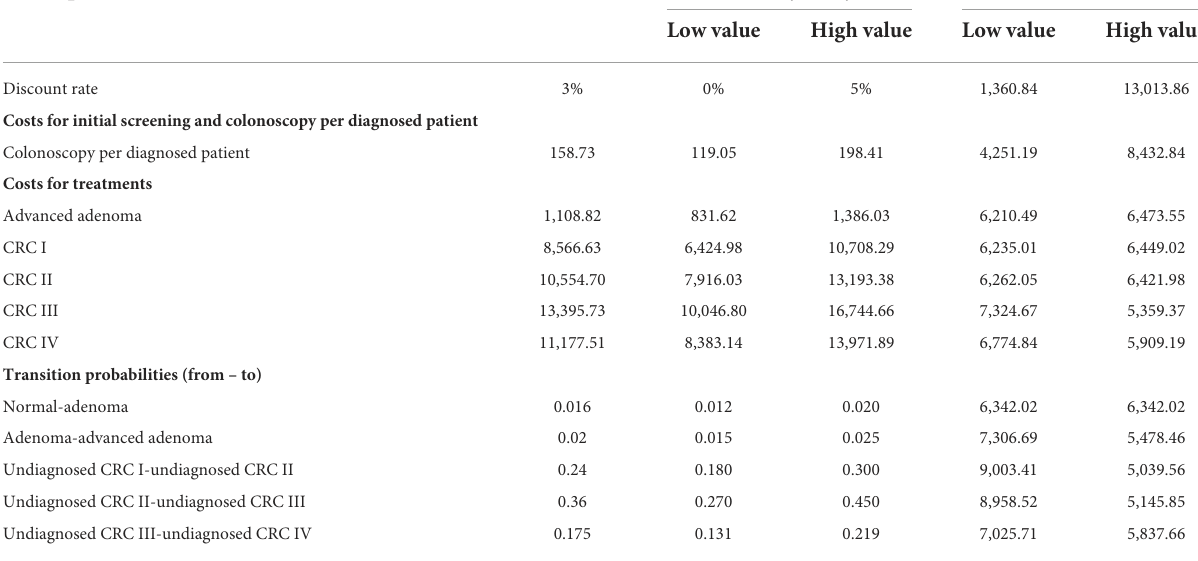
TABLE 5 One-way analysis of the parameters in the Markov model. Model